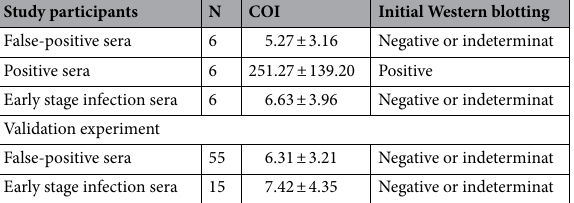
Table 2. Results of 88 serum samples detected by different methods. COI cut-off